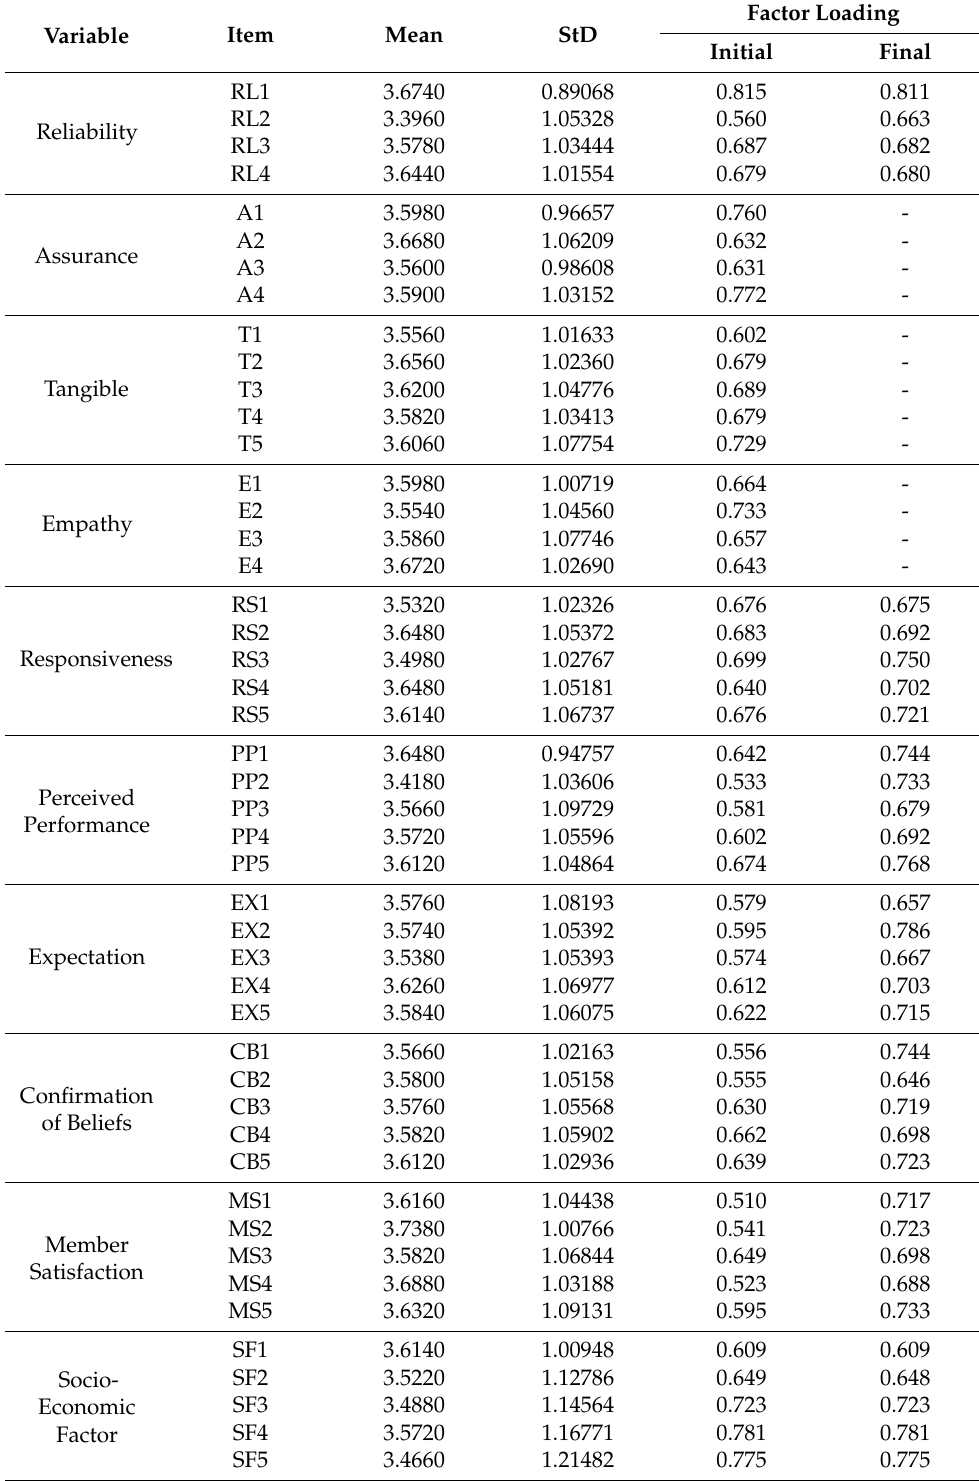
Table 4. Indicators statistical